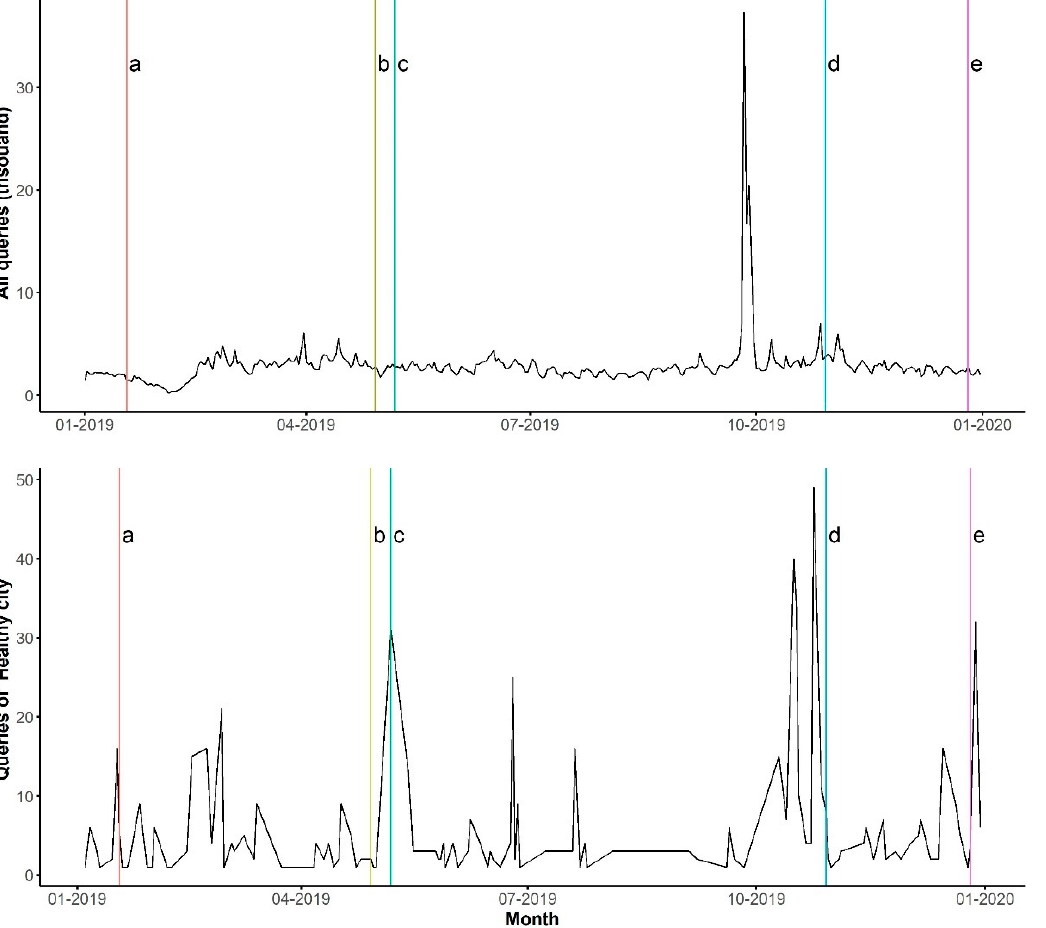
Figure 5. Time series of the search queries on all keywords (upper) and the search queries on the keyword “Healthy city” (bottom) in Shenzhen. Alphabetic letters indicated the major events relevant to the healthy city project in the city.